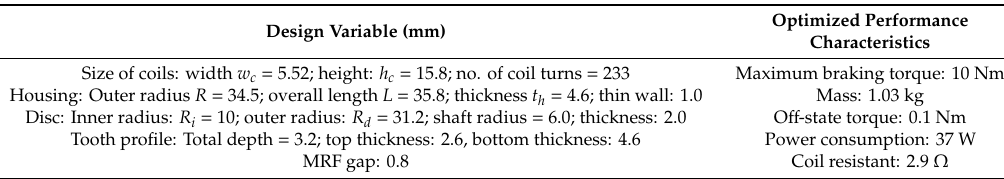
Table 1. Optimal results of the rotary MR